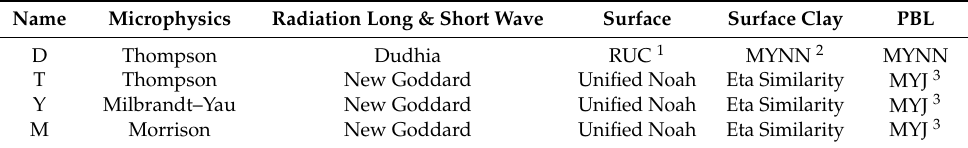
Table 1. Physics combinations used for deterministic simulations.